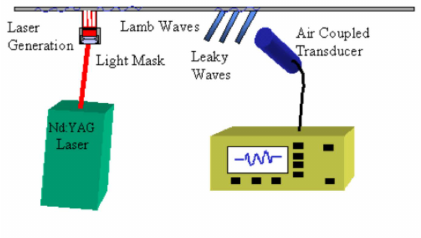
Figure 22. LT method (Schematic layout)